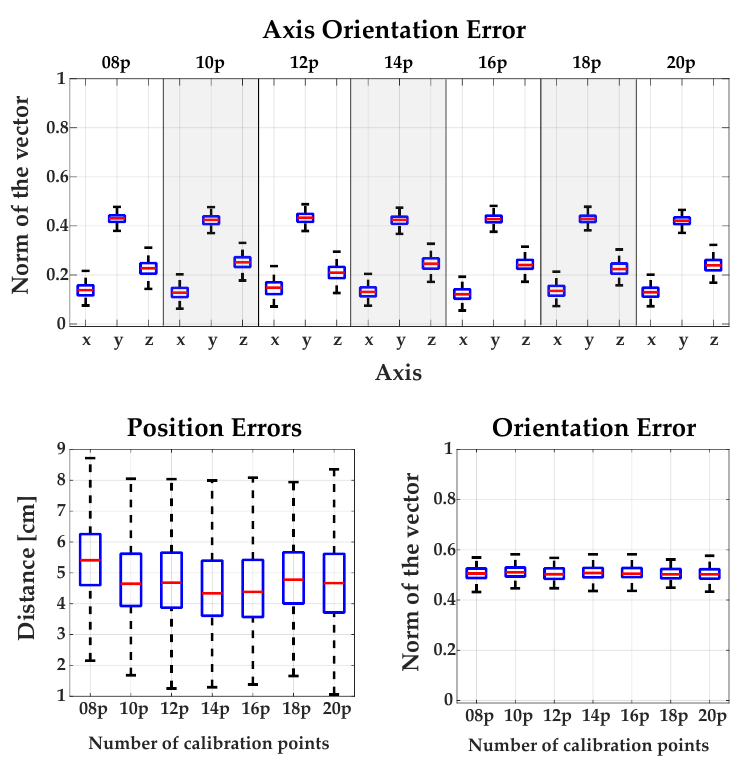
Figure A5. Results obtained by the XS2 calibration method using different numbers of calibration